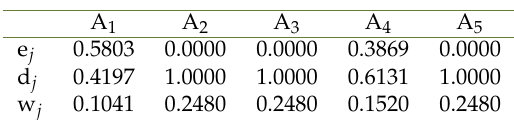
Table 5. The entropy measures, divergence degrees, and